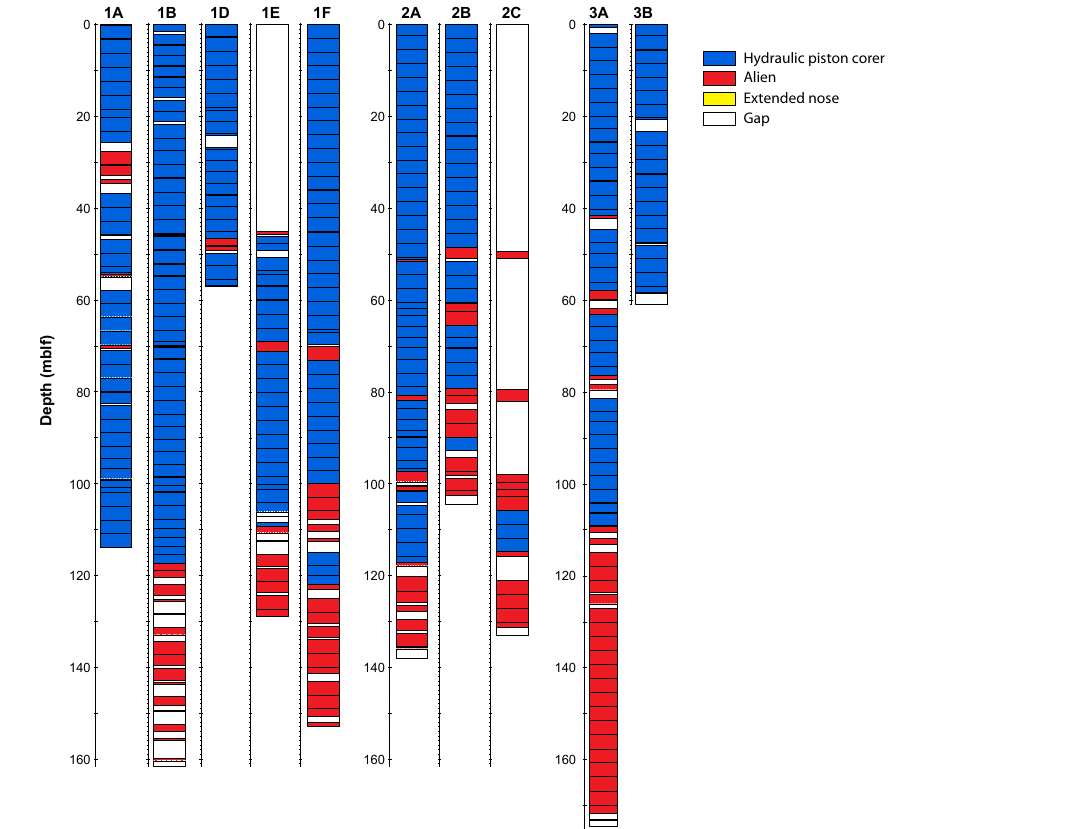
Figure 5. Core recovery from the TDP drill sites in Lake Towuti. Colors indicate the various tools used to recover cores from all TDP sites except 1C. White boxes indicate intervals that were not